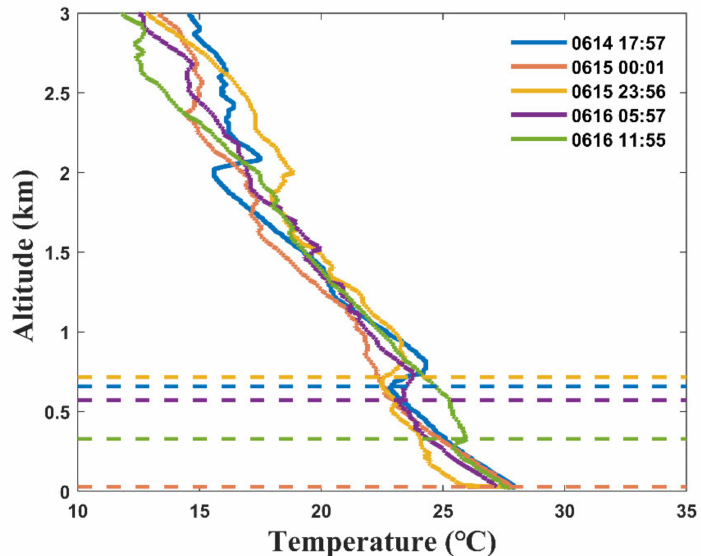
Figure 9. Temperature profile measured at 5 times (BJT): 17:57 14 June 2019 (blue), 00:01 15 June 2019 (red), 23:56 15 June 2019 (yellow), 05:57 16 June 2019 (purple), 11:55 16 June 2019 (green). The dotted lines are the bottom heights of the inversion layer at the corresponding time.